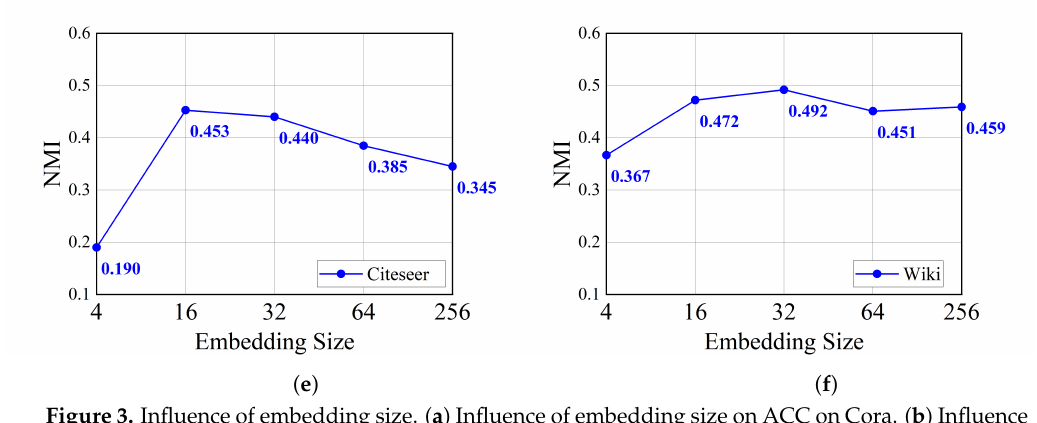
Figure 3. Influence of embedding size. ( a ) Influence of embedding size on ACC on Cora. ( b ) Influence of embedding size on ACC on Citeseer. ( c ) Influence of embedding size on ACC on Wiki. ( d ) Influence of embedding size on NMI on Cora. ( e ) Influence of embedding size on NMI on Citeseer. ( f ) Influence of embedding size on NMI on Wiki.